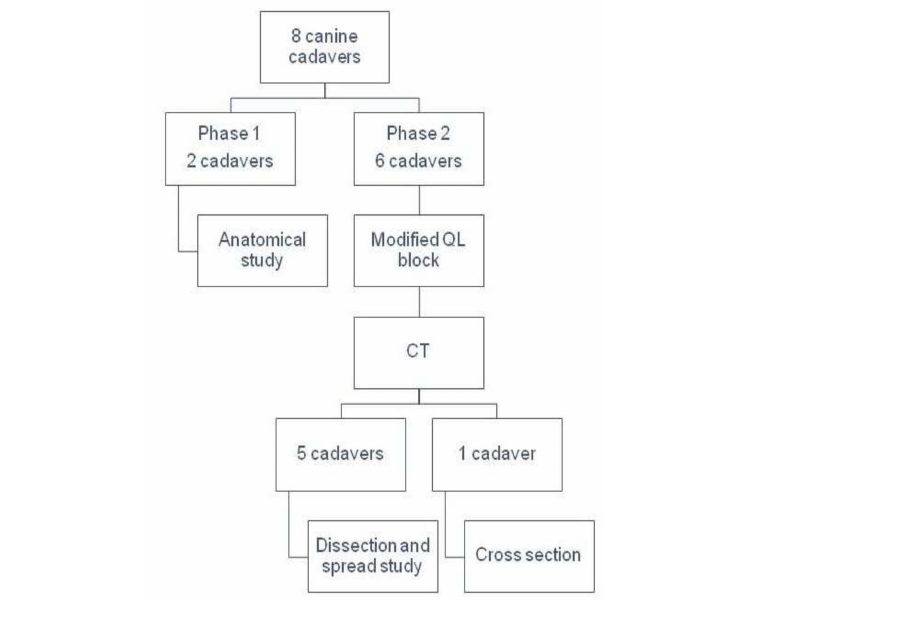
Figure 1. Schematic diagram of the experimental design. CT, computed tomography; QL, quadratus